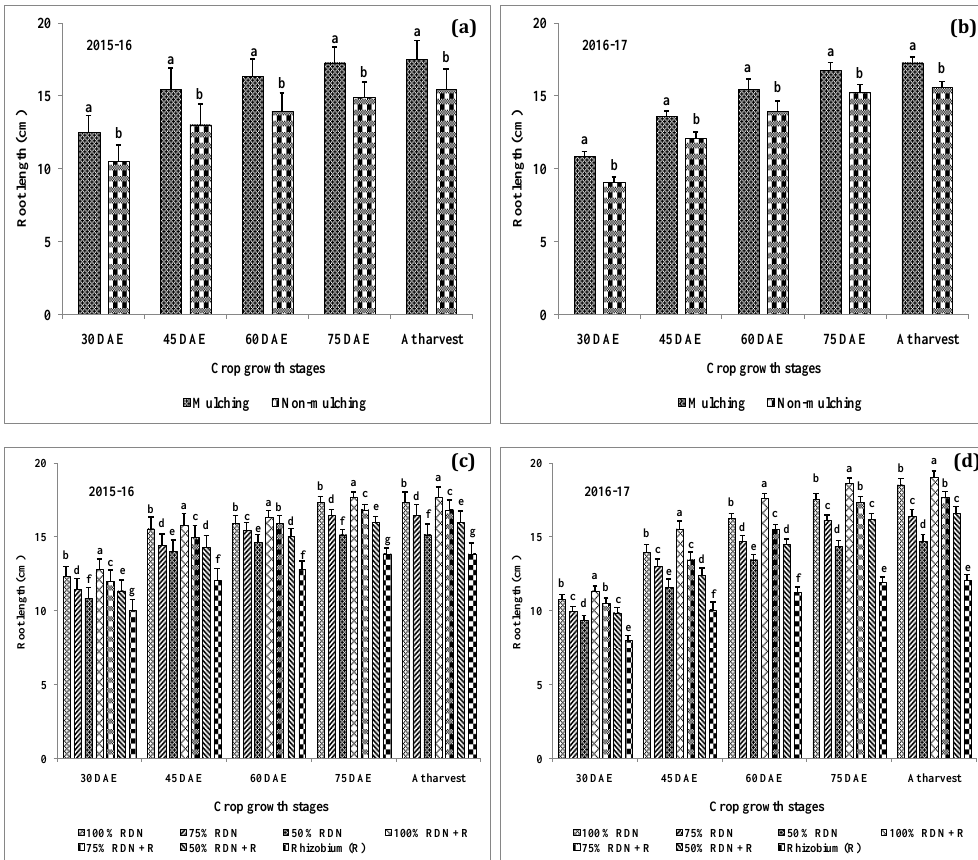
Figure 2. E ff ect of soil mulch ( a , b ) and nutrient management ( c , d ) on peanut root length at di ff erent growth stages (data from 2015–2016 and 2016–2017 crop seasons, respectively). DAE—days after emergence; error bars represent the least significant di ff erence values. Di ff erent letters on the bars indicate significant di ff